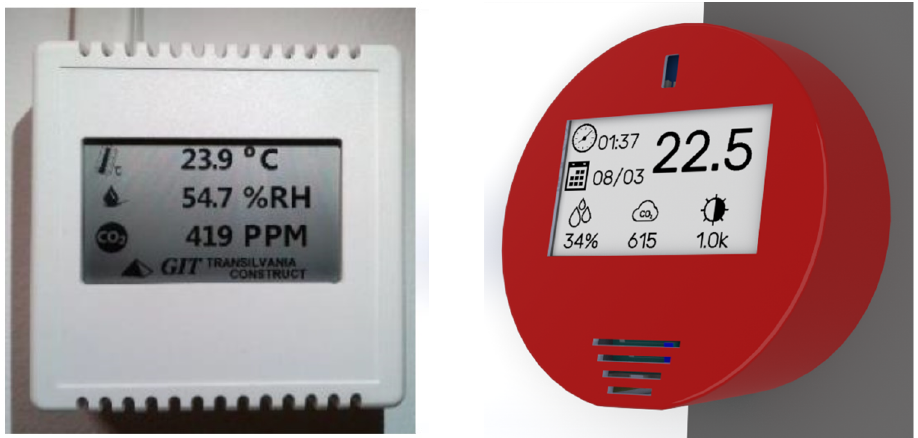
Figure 10. Sensors for air temperature, humidity, and CO 2 content (Ref. [50]).